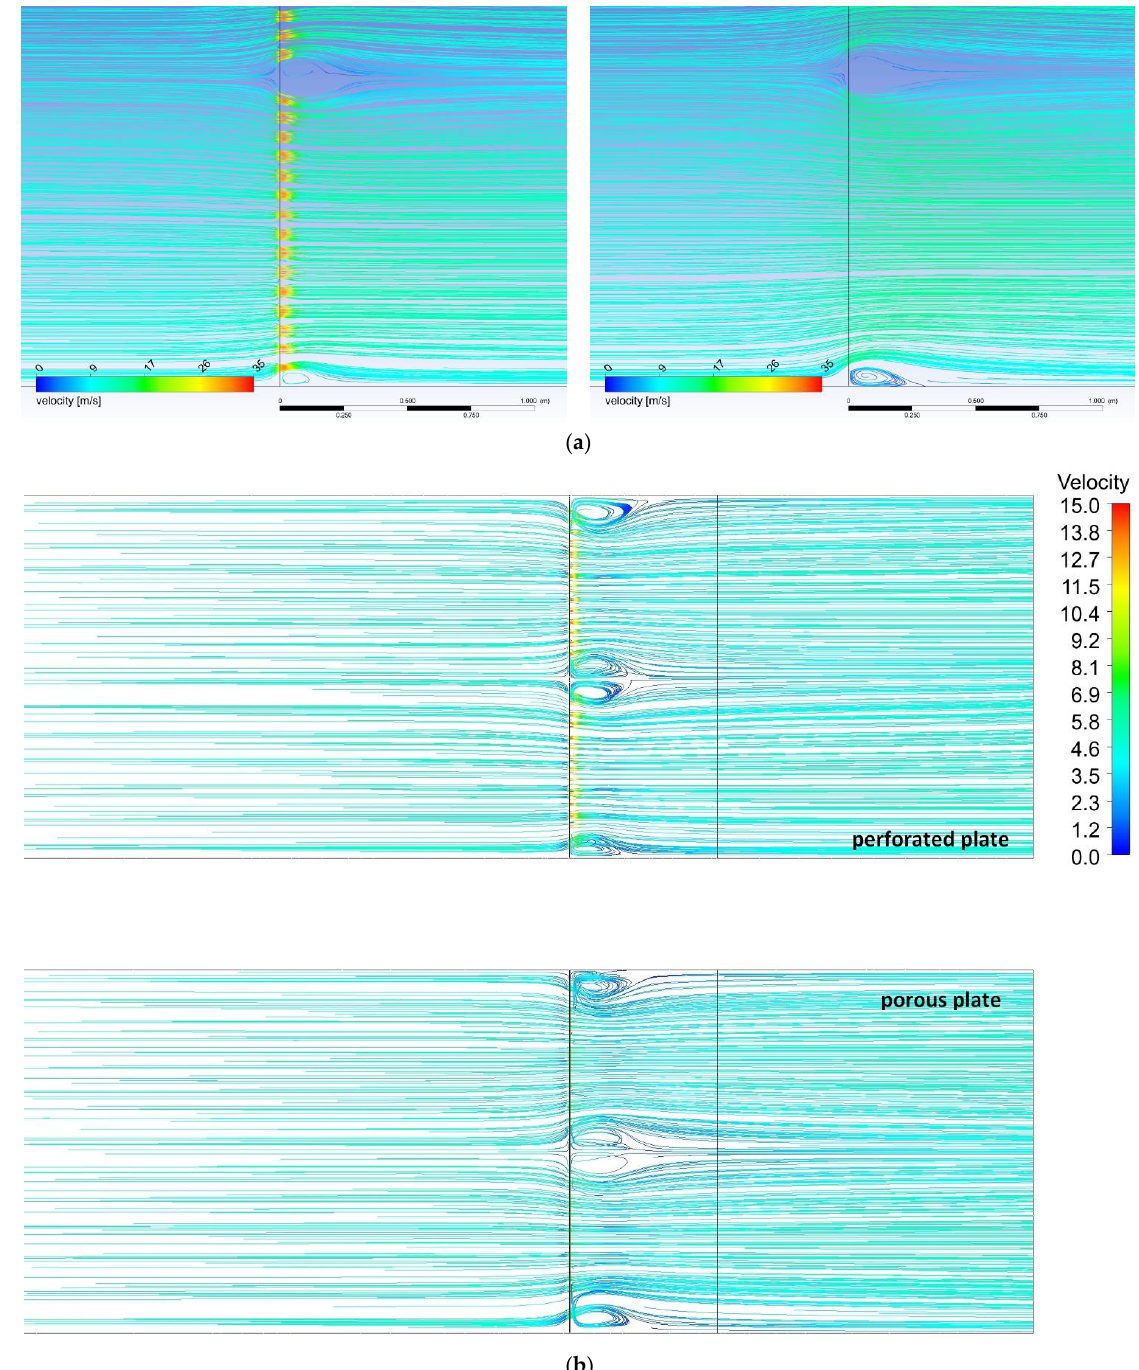
Figure 12. Isometric view on pathlines for four plate panels with open area ratio f = 0.40 ( left ) and corresponding porous core ( right ), u inlet = 10 m/s.